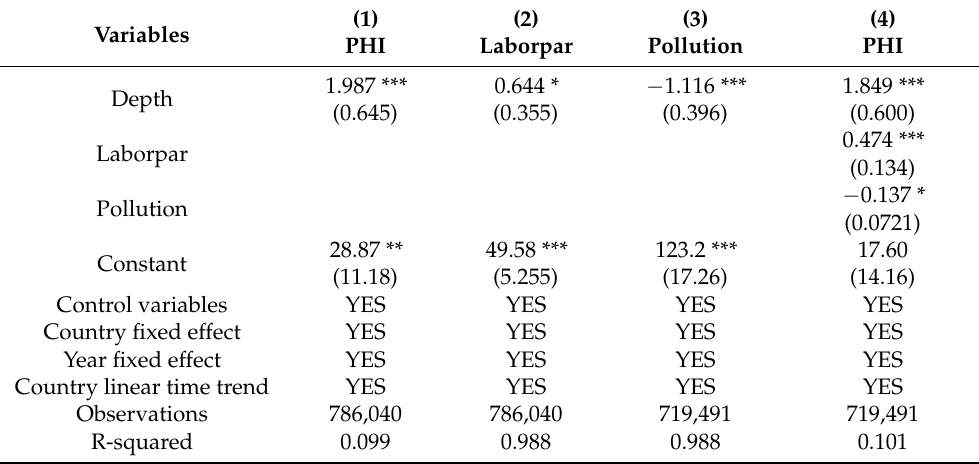
Table 7. Mechanism test